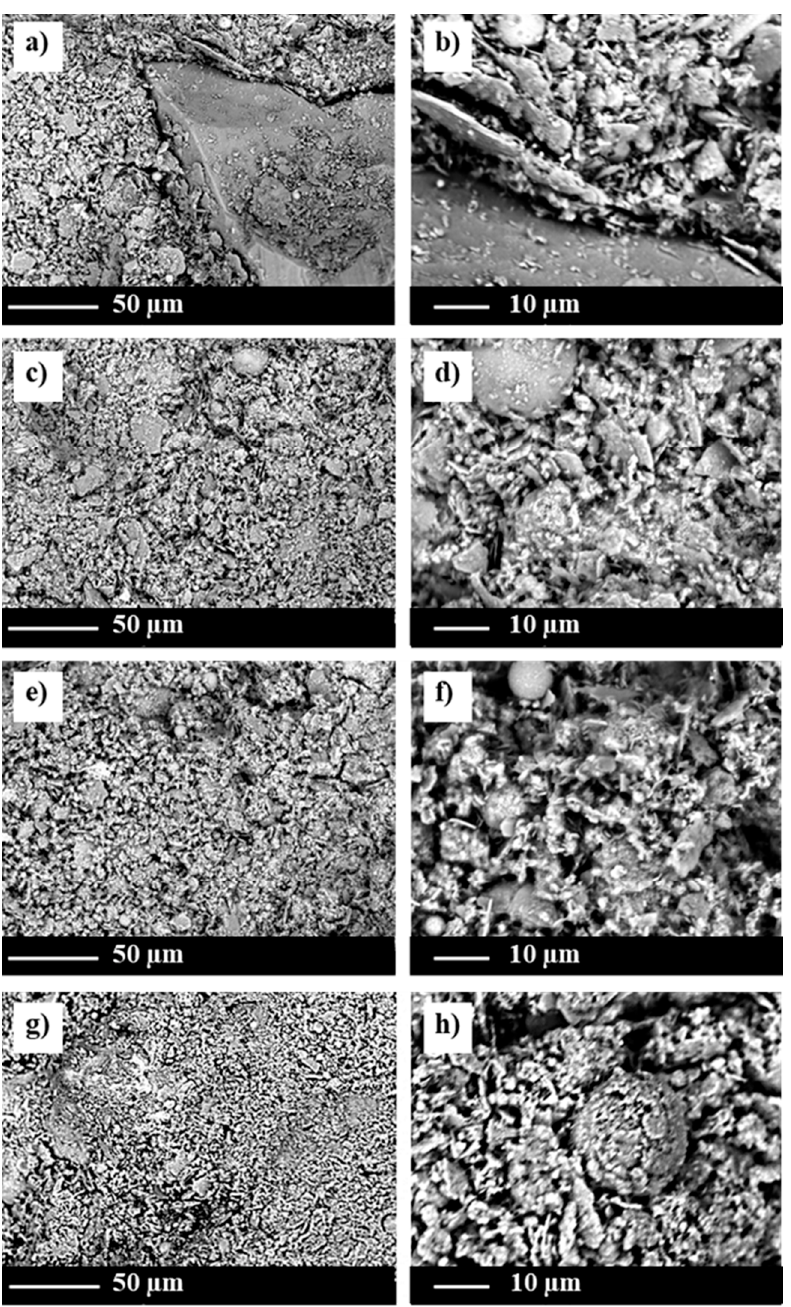
Figure 7. SEM images of one-part alkali activated mortars: ( a ) and ( b ) ASH_MK_0.5; ( c ) and ( d ) ASH_MK_1.5; ( e ) and ( f ) ASH_MK_2.5b; ( g ) and ( h )